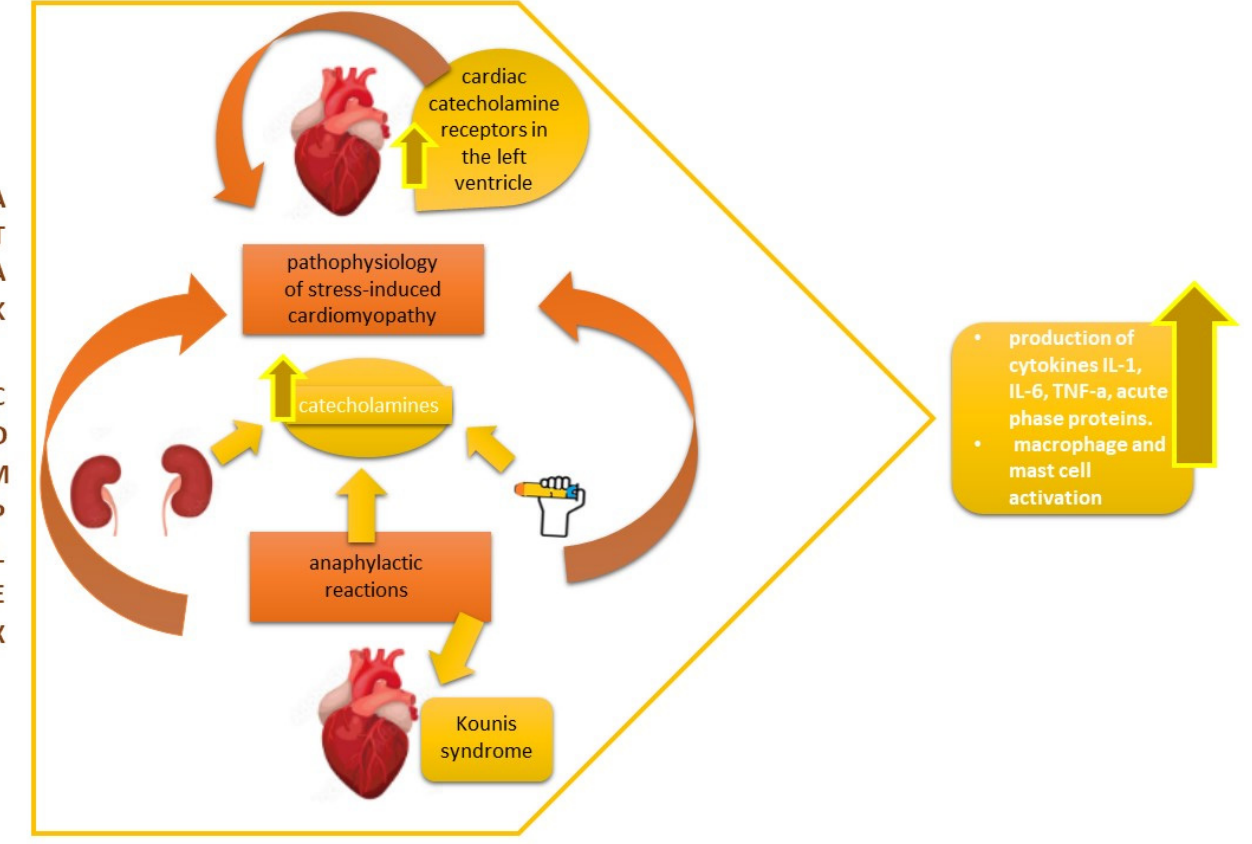
Figure 1. ATAK complex.